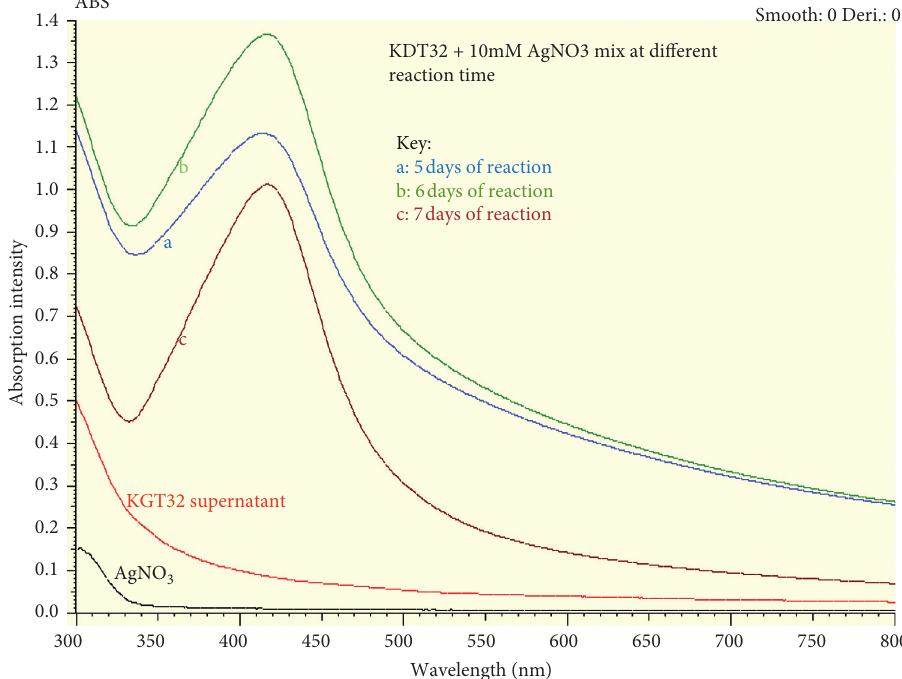
Figure 3: Comparison of absorption intensity of KGT32-AgNPs with respect to reaction